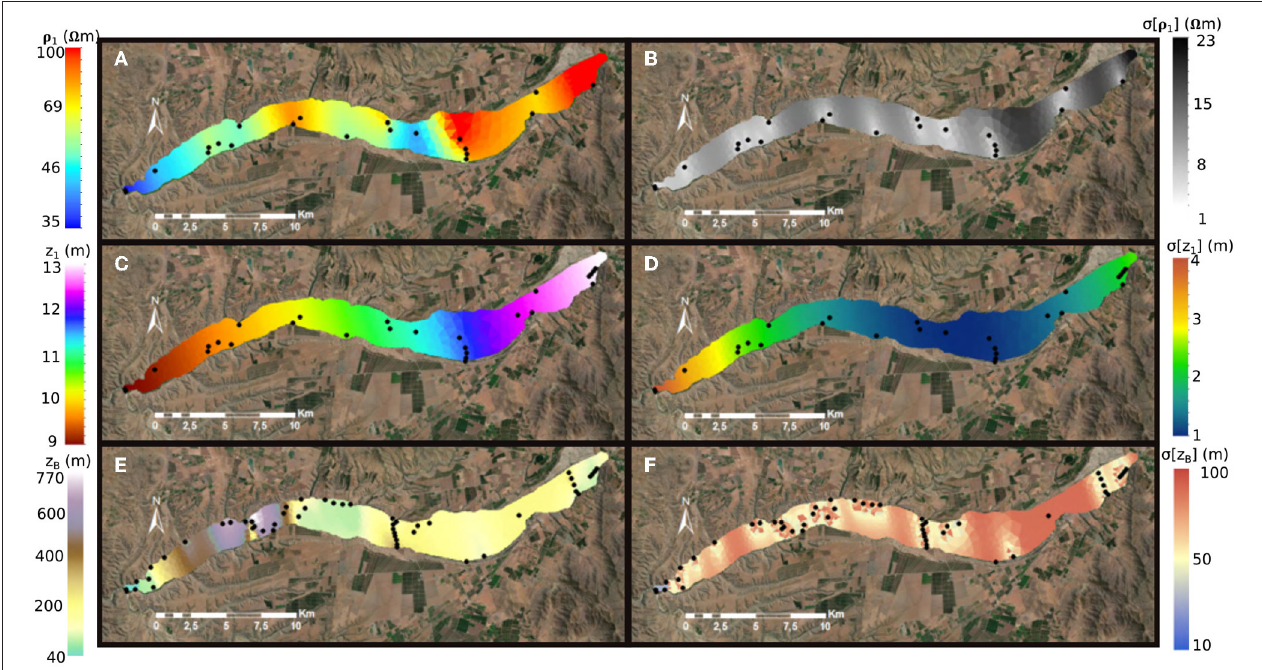
FIGURE 11 | Example of 2D layer interpolation for the sector Limarí river upstream of Altos de Talinay. Interpolated surfaces of the first layer (A) resistivity ( ρ 1 ), (B) resistivity total uncertainty ( σ [ ρ 1 ]; from Equation (2)), (C) depth to layer bottom ( z 1 ), and (D) depth to layer bottom total uncertainty ( σ [ z 1 ]; from Equation 2). The depth to the bedrock (E) and its total uncertainty (F) were obtained incorporating gravimetry data to the 2D kriging interpolation. For each interpolated quantity we represented the conditioning data location as black dots.